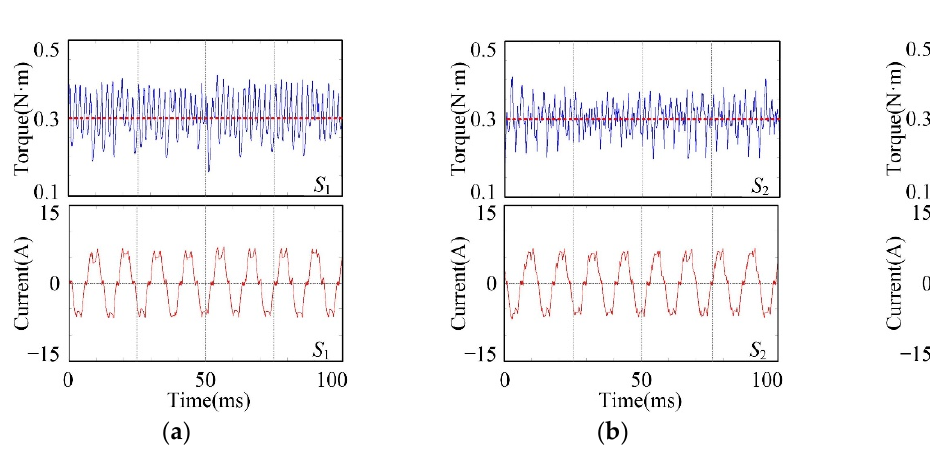
Figure 15. ( a ) Waveforms of torque and phase A current of S 1 under condition 2; ( b ) Waveforms of torque and phase A current of S 2 under condition 2; ( c ) Waveforms of torque and phase A current of S 3 under condition 2.